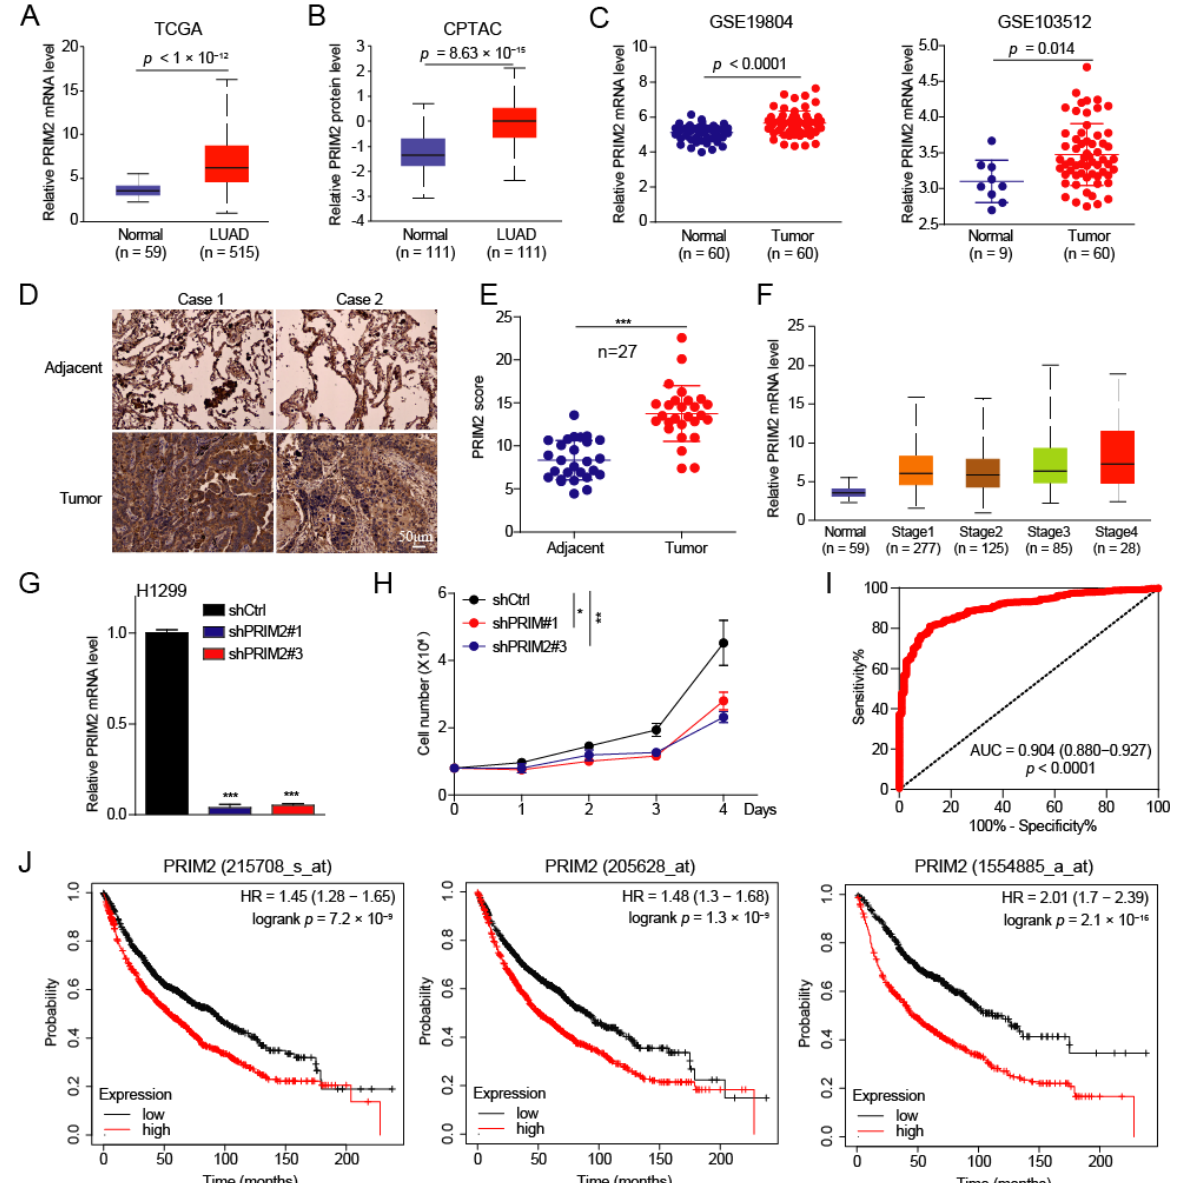
Figure 1. PRIM2 is upregulated and associated with prognosis in lung cancer. ( A – C ) The PRIM2 mRNA and protein expression levels were analyzed in tumor and normal tissues. ( D , E ) The expression of PRIM2 was examined in lung tumor and adjacent tissues of lung cancer patients by immunohistochemical (IHC) analysis. ( F ) The PRIM2 mRNA levels were analyzed for different stages of tumor and normal tissues. ( G ) The PRIM2 mRNA expression levels in H1299 cells with PRIM2 knockdown. ( H ) The cell growth in H1299 cells with PRIM2 knockdown. ( I ) ROC curve analysis indicated that PRIM2 could efficiently distinguish a lung cancer patient from a normal individual.